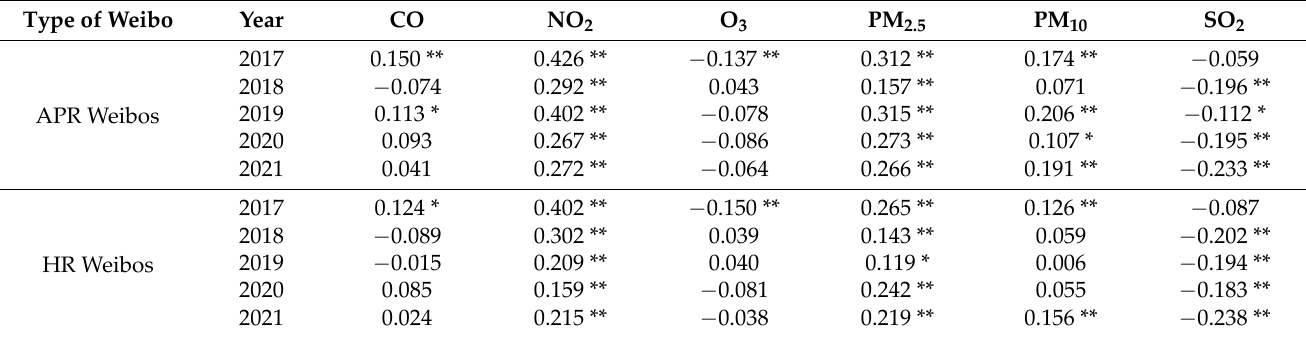
Table 3. Correlation between pollutant concentrations and APR or HR Weibos in each year of